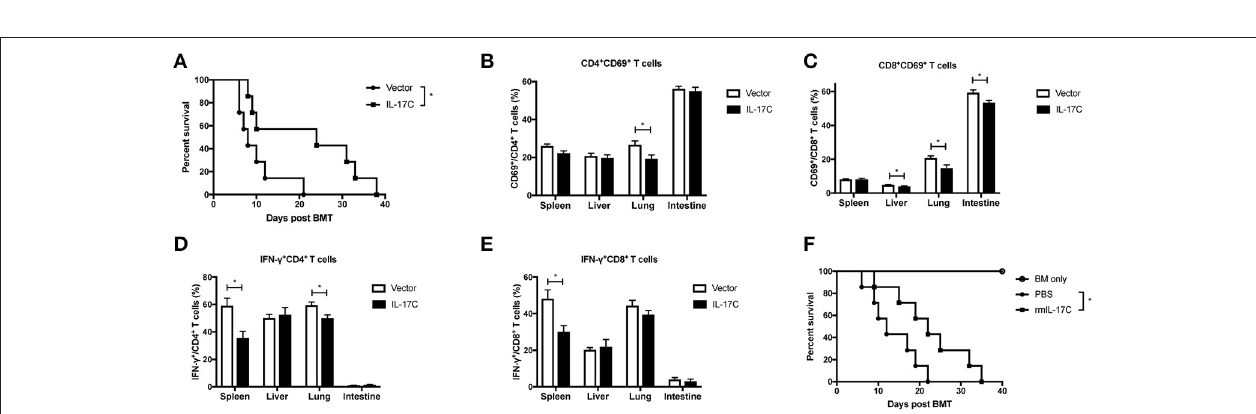
FIGURE 3 | Overexpression IL-17C ameliorates aGVHD. Vector plasmid or minicircle-IL-17C plasmid was injected into BALB/C recipients by hydrodynamic gene transfer (HGT) 3 days before transplantation. Recipients were lethally irradiated and transplanted with 1 × 10 ∧ 7 bone marrow cells and 5 × 10 ∧ 6 splenocytes from IL-17C − / − mice. ( A ) aGVHD-related survival; n = 7 per group. ( B ) Percentages of CD69 + CD4 + T cells ( B ) and CD69 + CD8 + T cells ( C ) in spleen, liver, lung, and intestine were detected on day 14 post-transplantation; n = 6 per group. Percentages of IFN- γ -producing CD4 + T ( D ) and CD8 + T ( E ) cells were examined by intracellular staining. ( F ) BALB/C recipients were transplanted with 1 × 10 ∧ 7 bone marrow cells together with 5 × 10 ∧ 6 splenocytes or 1 × 10 ∧ 7 bone marrow cells from IL-17C − / − mice. Recipients were administrated with PBS or rmIL-17C every 3 days. BM only, n = 3; PBS, n = 7; rmIL-17C, n = 7. Data are representative of at least three experiments and presented as mean ± SEM. * P <